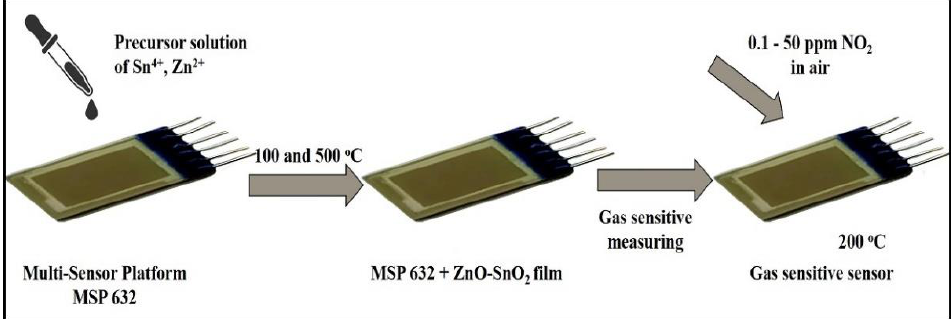
Figure 1. Gas sensor formation scheme.